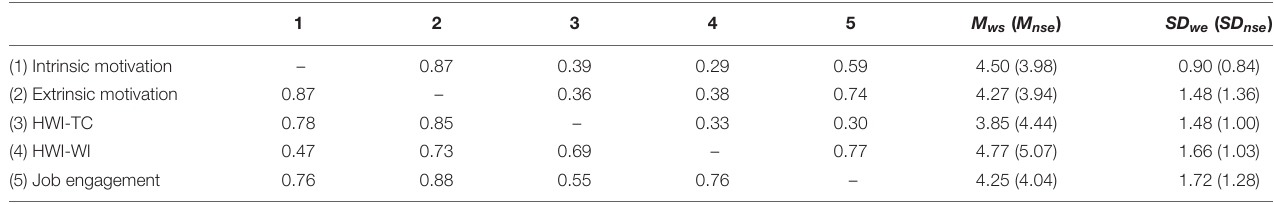
TABLE 2 | Pearson correlation matrix for working students ( below the diagonal; n = 77) and non-student employees ( above the diagonal; n = 165), means and standard deviations in the Israeli sample ( N = 242). 1 2 3 M ws ( M nse )